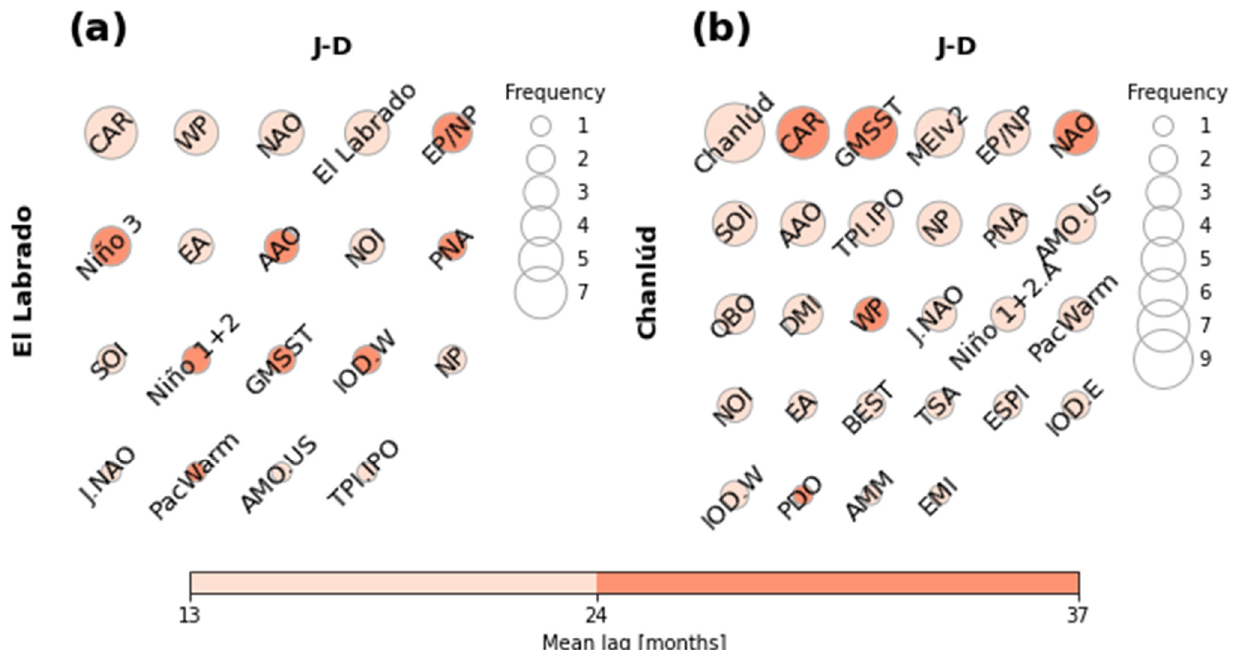
Figure 8. Predictors selected through SFS for each annual model: ( a ) model for El Labrado (dots in Figure 4c); ( b ) model for Chanlúd (dots in Figure 4f). The size of each circle corresponds to the frequency with which a climate index (with different lags) appears as a predictor of the model. The color of each circle corresponds to the mean of the lags with which a climate index appears as a predictor of the model.